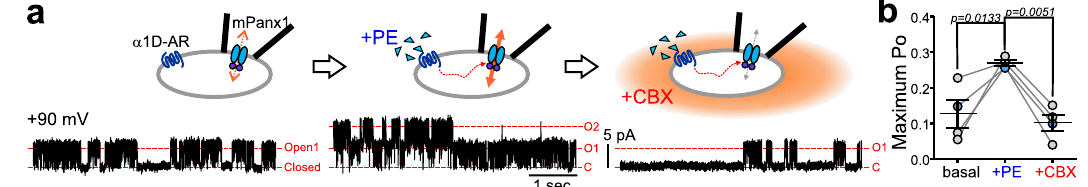
Fig. 1 Panx1 channel activation by α 1D-ARs requires a diffusible messenger. a Exemplar cell-attached patch recording shows phenylephrine (PE, 20 μ M)- induced activation of carbenoxolone (CBX, 50 μ M)-sensitive channels in HEK293T cells expressing α 1D-adrenergic receptors ( α 1D-ARs) and mPanx1. The schematic illustrates that, in this con fi guration, the liganded α 1D receptor is physically separated from the recorded channel in the patch pipette, activation of which must involve a diffusible messenger. b Effects of PE and CBX on channel activity (maximum P O ) in those cell-attached patches ( n = 4 membrane patches examined over 4 independent experiments). Data from the exemplar patch recording (in a ) is represented by cyan dots. One-way ANOVA (F 2,9 = 11.35, p = 0.0035) with Bonferroni ’ s multiple comparisons test ( p values from comparisons are